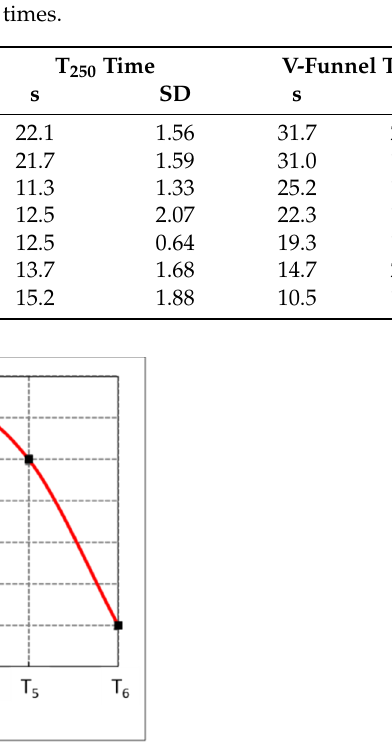
Figure 2. Variation of flow spread with SF content.